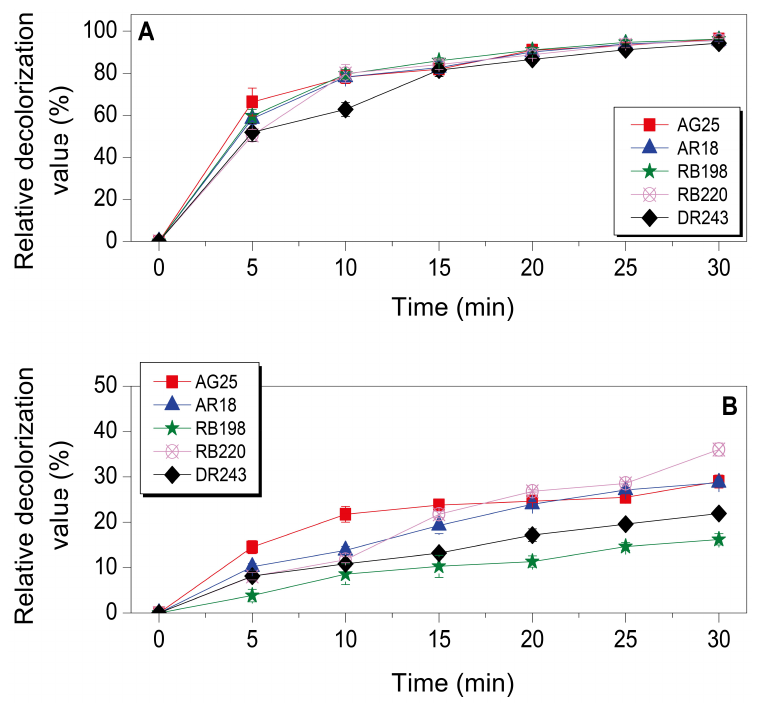
Figure 6. Dye decolorization of bacCTS-MB1s ( A ) and CTS-MB1s ( B ) towards AG25, AR18, RB198, RB220 and DR243. Decolorization was performed using 2 g of the bacCTS-MB1s or CTS-MB1s (wet weight) at 28 °C and pH 2.5 with shaking at 180 rpm for 30 min.